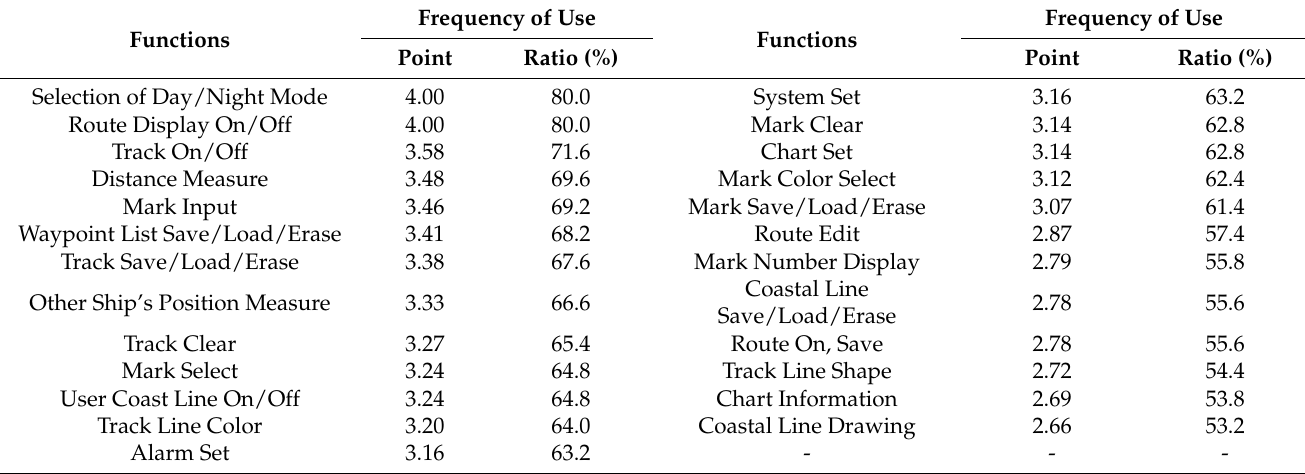
Table 3. User survey results on the frequency of use for GPS-plotter